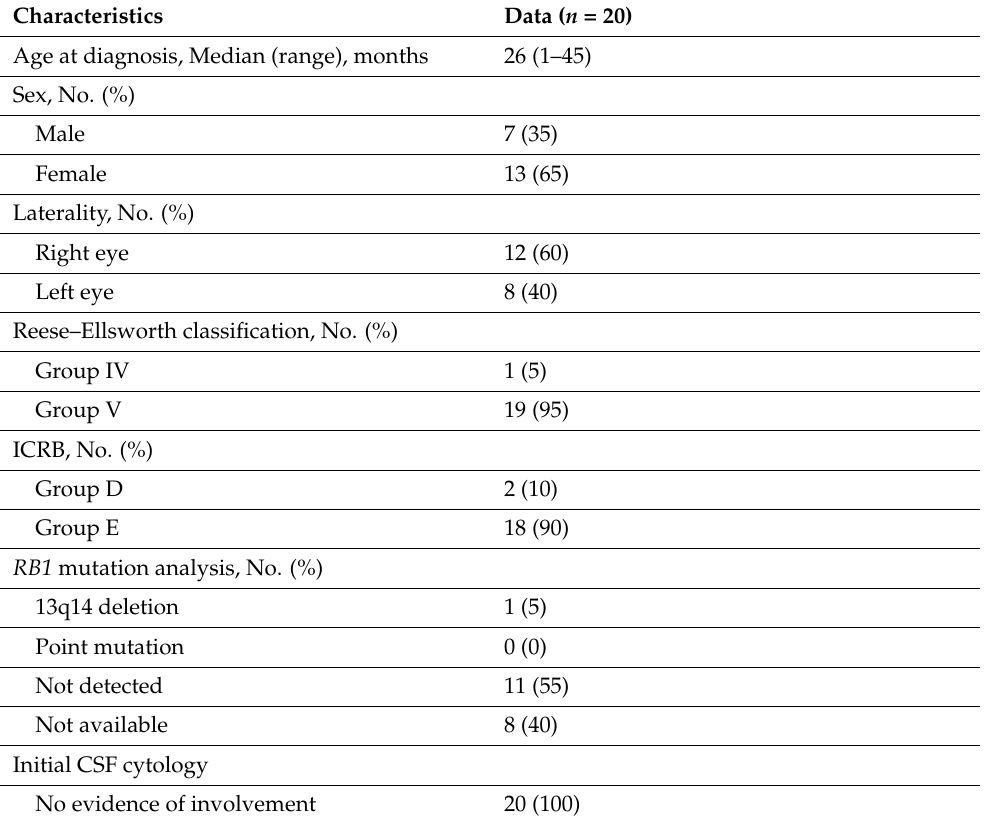
Table 1. Baseline patient